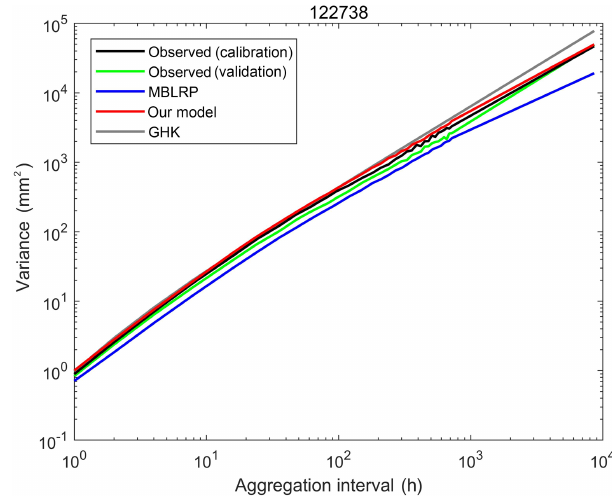
Figure 10. Behaviour of the rainfall variance with regard to the ag- gregation interval of rainfall time series at gauge NCDC-122738. The behaviour corresponding to the observed calibration (black, 1981–2010), observed validation (green, 1951–1980), MBLRP (blue) and our hybrid model (red) is shown